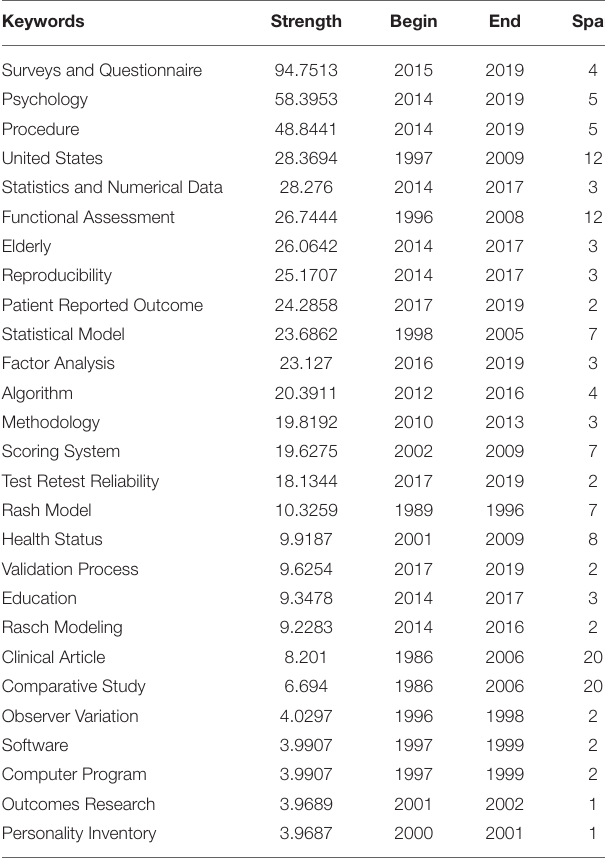
TABLE 5 | Sample keyword bursts computed via co-occurring author keywords analysis and keyword